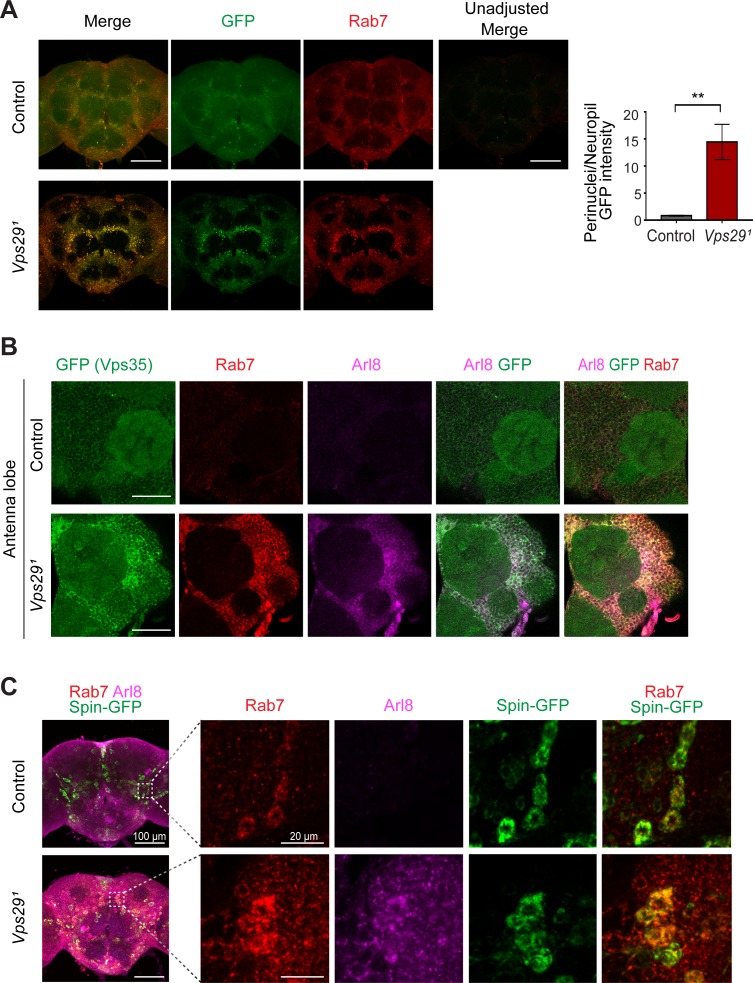
Loss of Vps29 causes mislocalization of Rab7.(A) In the absence of Vps29, Rab7 protein is increased and mislocalized to neuronal soma. Vps291;Rab7EYFP homozygotes or control (Rab7EYFP) animals, harboring an endogenous, EYFP-tagged Rab7, were stained for Rab7 protein, using both anti-GFP (green) and anti-Rab7 (red). The fluorescence intensity of control animals was amplified for visualization of the weak signal (imaging using consistent settings for controls shown at right). The GFP intensity ratio (perinuclear to neuropil) was quantified (n = 4) within antennal lobe region in 2-day-old animals. Scale bars, 100 µm. (B) In Vps29 mutants, Vps35GFP (green) colocalizes with both Rab7 (anti-Rab7, red) and Arl8 (anti-Arl8, magenta). Scale bars, 50 µm. (C) In 1-day-old Vps29 mutants, the increased Rab7- (anti-Rab7, red) and Arl8-postive signal (anti-Arl8, magenta) exhibits a punctate, cytoplasmic distribution that further co-stains with Spinster-GFP, which was expressed in neurons. The following genotypes were examined: Vps291; nSyb-Gal4/UAS-Spinster-GFP and nSyb-Gal4/UAS-Spinster-GFP (control). Statistical analysis based on Student’s t test. All error bars denote SEM. **, p<0.01.